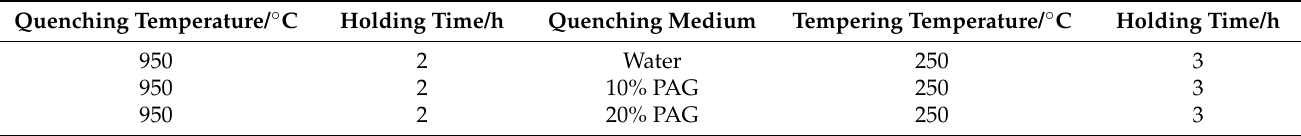
Table 2. Heat treatment parameters of high chromium cast